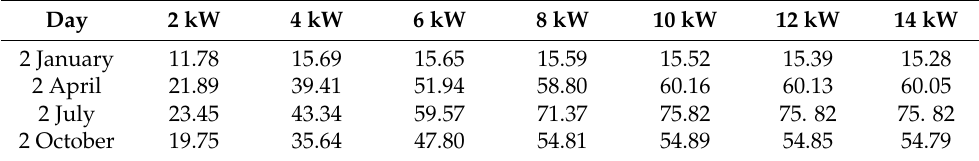
Table 4. Daily electrolyzer energy consumption (kWh) at several capacities for selected days.